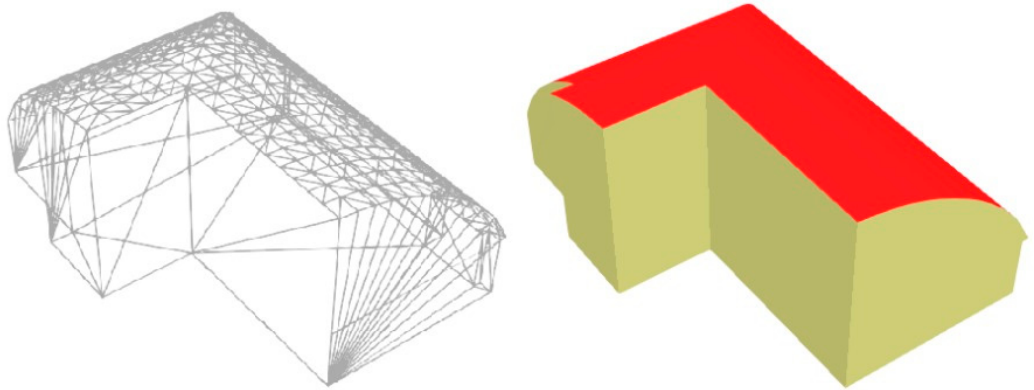
Figure 4. Geometry visualized by Cesium library.